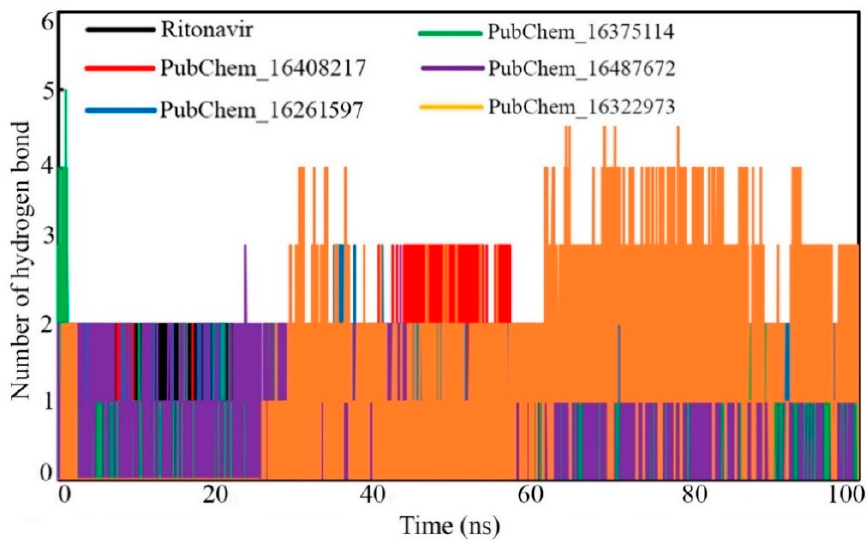
Figure 13. Number of hydrogen bonds vs. time of simulation.